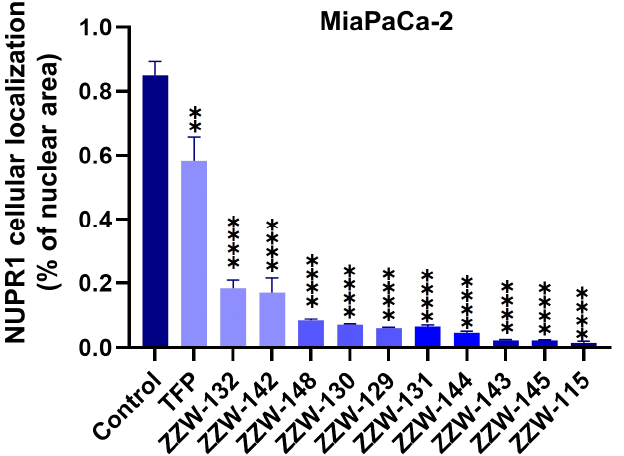
Figure 4. ZZW-115-derived compounds inhibited NUPR1 nuclear translocation. MiaPaCa-2 cells were treated with representative ZZW-115-derived compounds (3 µM) for 6 h. Immunofluorescence with rabbit anti-NUPR1 primary antibody and Alexa 488–labeled goat anti-rabbit secondary antibody were used to reveal the localization of the protein (n = 3). DAPI staining was used to detect cell nuclei, and it was combined with the Alexa 488 fluorescence in the merged panel. The y -axis indicates the fraction of area within the nucleus where the presence of NUPR1 was observed. **P < 0.01; ****P < 0.0001 (1-way ANOVA, Tukey’s post hoc test).